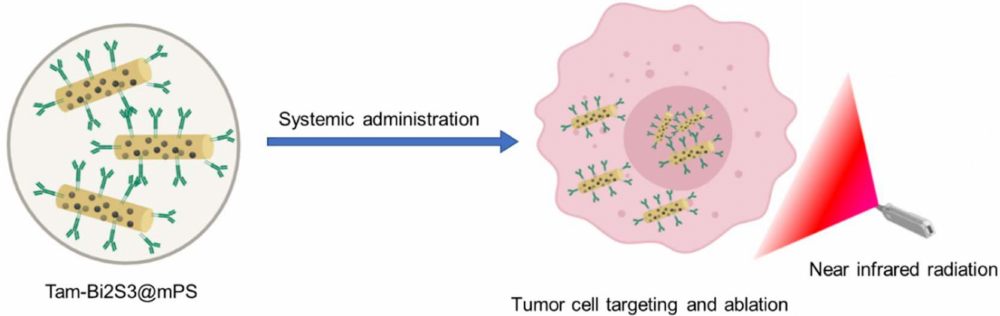
Figure 5. Diagrammatic presentation of the targeted Tam-Bi2S3@mPS theranostic